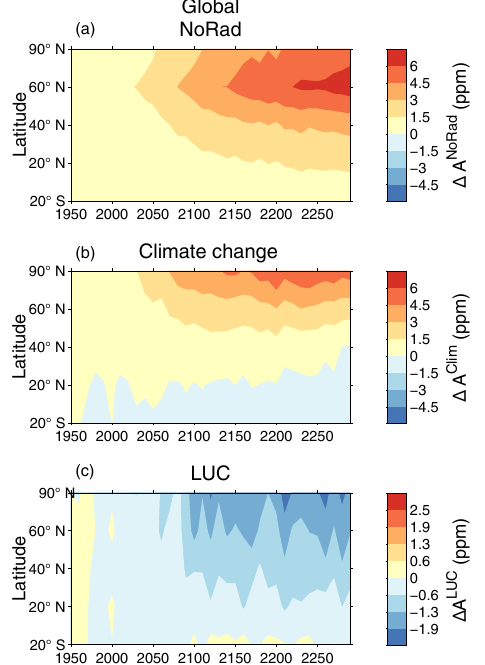
Figure 8. Changes in the decadal mean atmospheric CO 2 annual cycle amplitudes from 1950–1959 values from (a) CO 2 fertilization and N deposition ( (cid:49)A NoRad ), (b) climate change ( (cid:49)A Clim ), and (c) land use change ( (cid:49)A LUC ) from all land regions in each latitude bin. Note that the color scale in (c) is different from the scale in (a, b) .